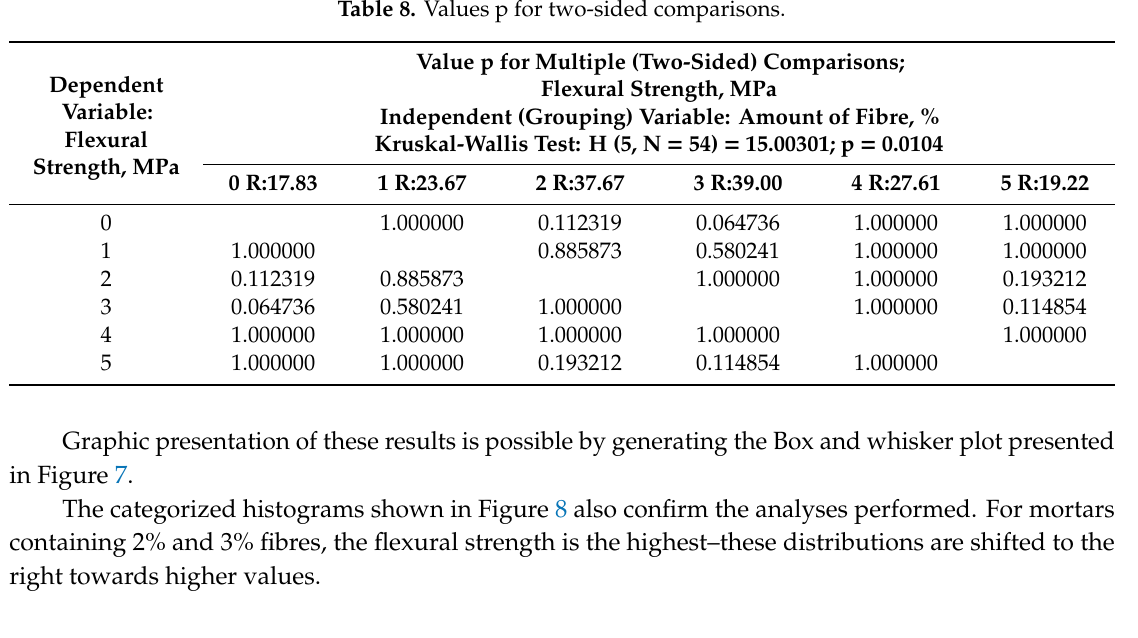
Table 8. Values p for two-sided